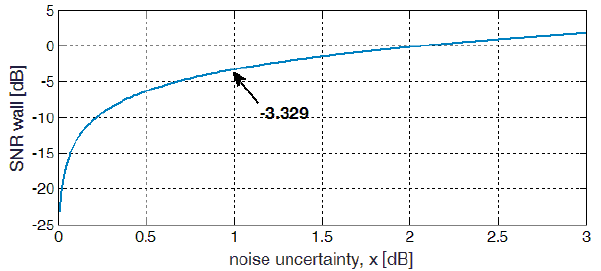
Figure 3. ‘ SNR Wall ’ in a noise uncertainty